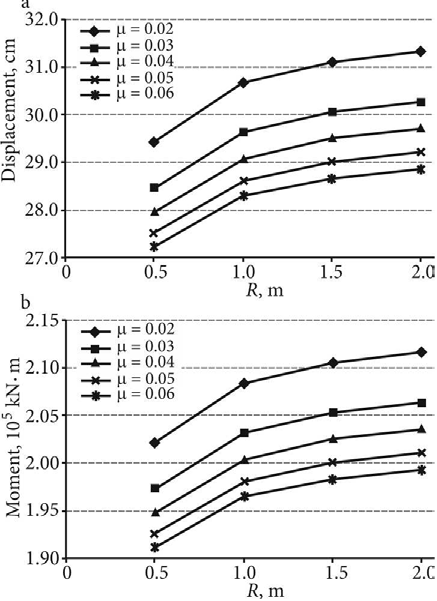
Fig. 5. Variation of the key displacement and moment with R and μ: a – maximum displacement of the girder; b – maximum moment at the bottom of the tower